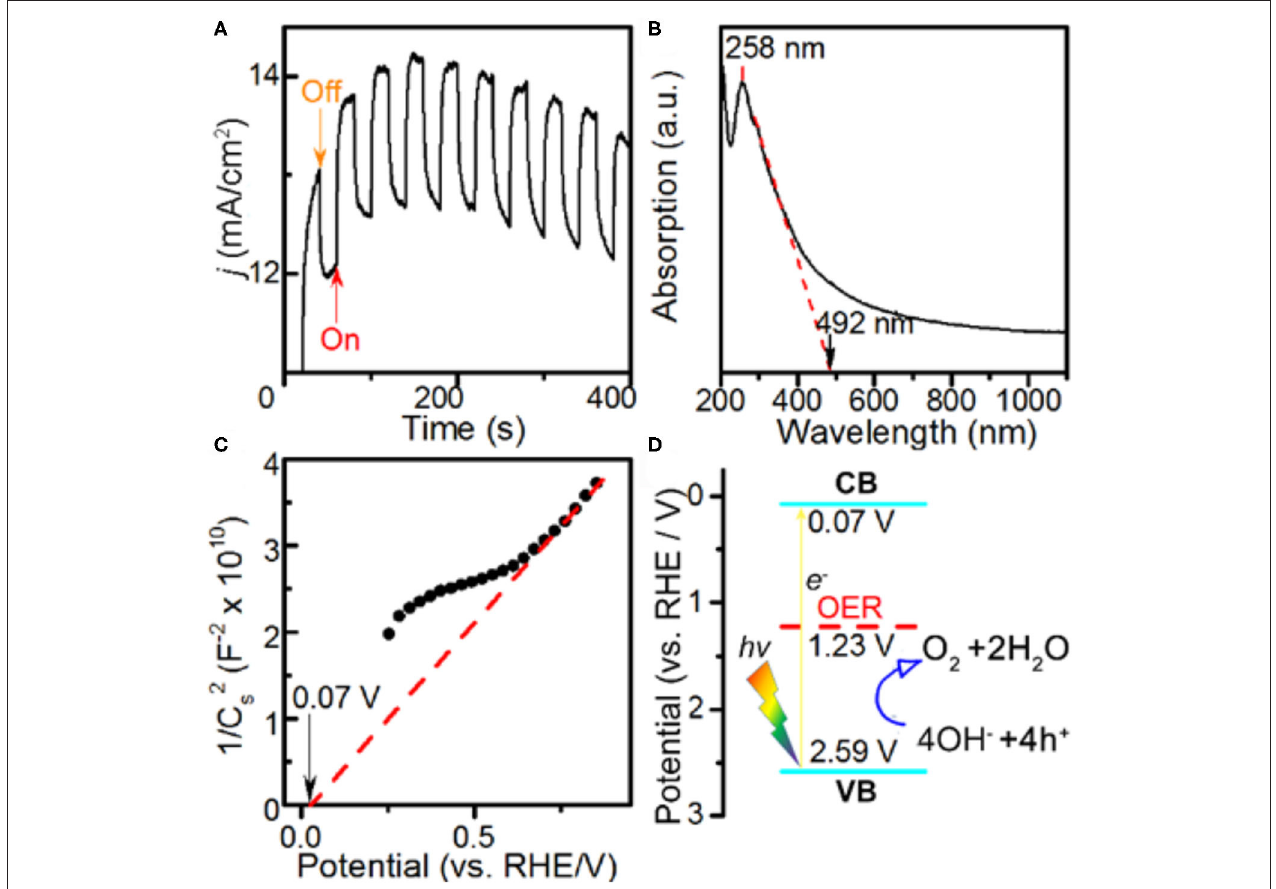
FIGURE 3 | Photoelectrochemical measurements in 1M KOH electrolyte and characterizations: (A) potentiostatic current response at E = 1.582V vs. reversible hydrogen electrode (RHE) with and without light illumination, (B) UV–Vis spectrum, (C) Mott–Schottky plot, and (D) band alignment of the Co-MOF nanosheets.